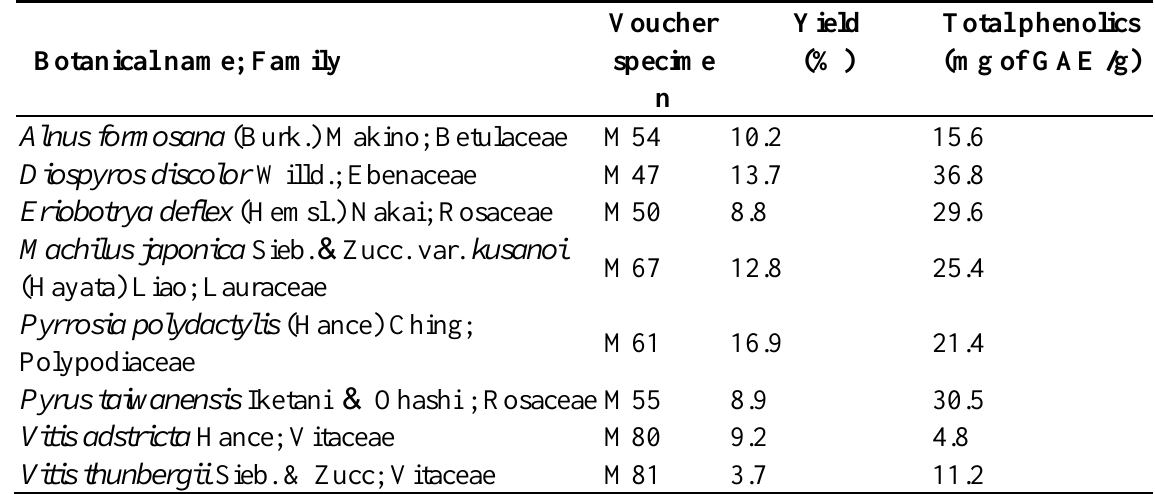
Table 1. Total phenolics content in Taiwanese Plants.